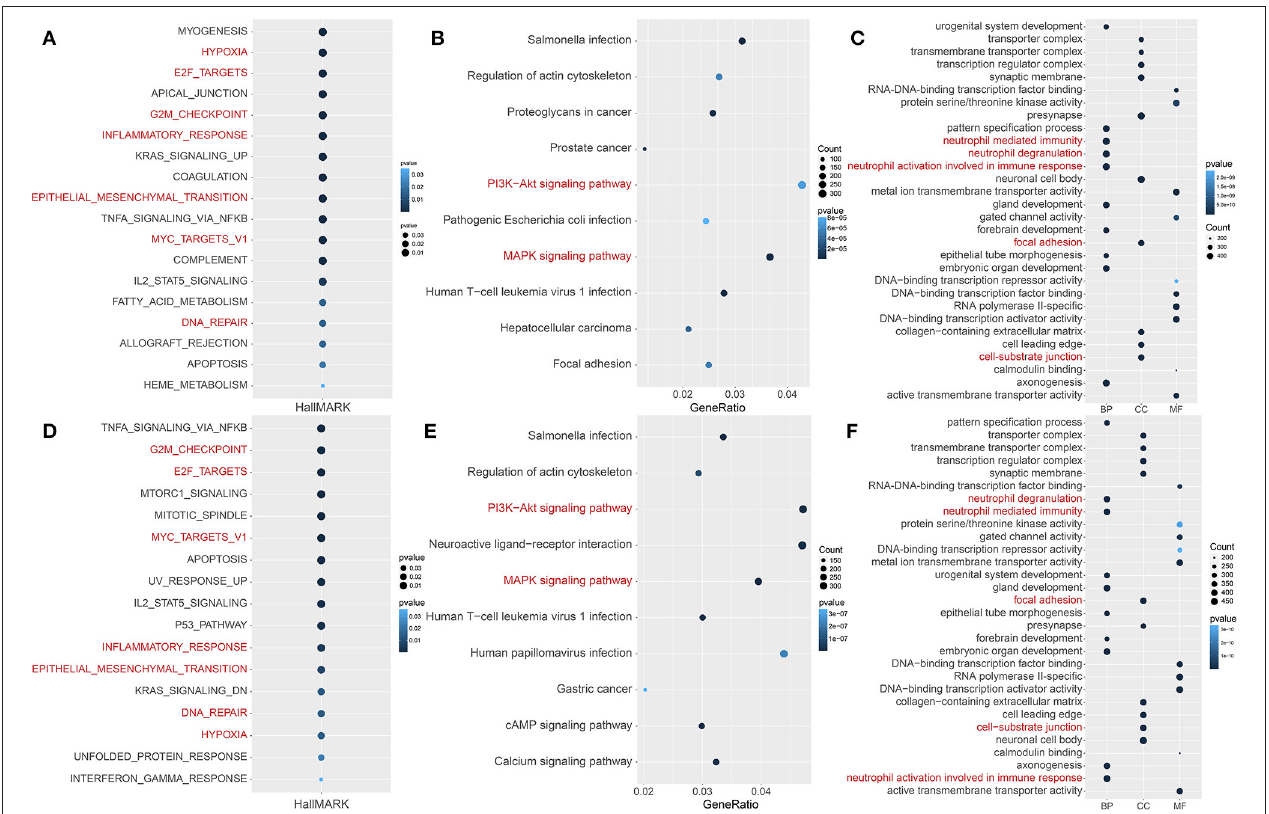
FIGURE 3 | Potential functional analyses in the GEO cohort. (A) GSVA analysis of hallmark pathways between the HRisk and LRisk groups was performed. (B,C) KEGG and GO pathway analyses of differentially expressed genes between HRisk and LRisk groups. (D) GSVA analysis of hallmark pathways between cluster 2 and cluster 3 groups was performed. (E,F) KEGG and GO pathway analyses of differentially expressed genes between cluster 2 and cluster 3 groups. GO, Gene Ontology; KEGG, Kyoto Encyclopedia of genes and genes; HRisk, high-risk; LRisk,